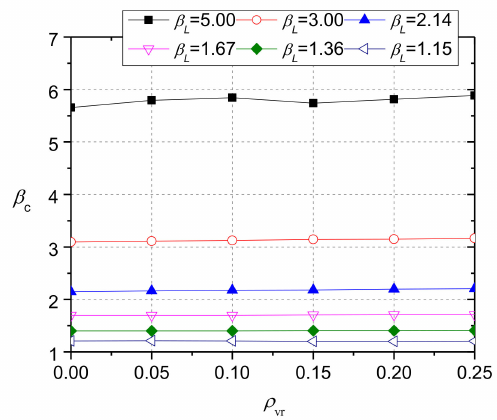
Figure 22. E ff ect of rubber content on the value of β c when concrete compressive strength is 25